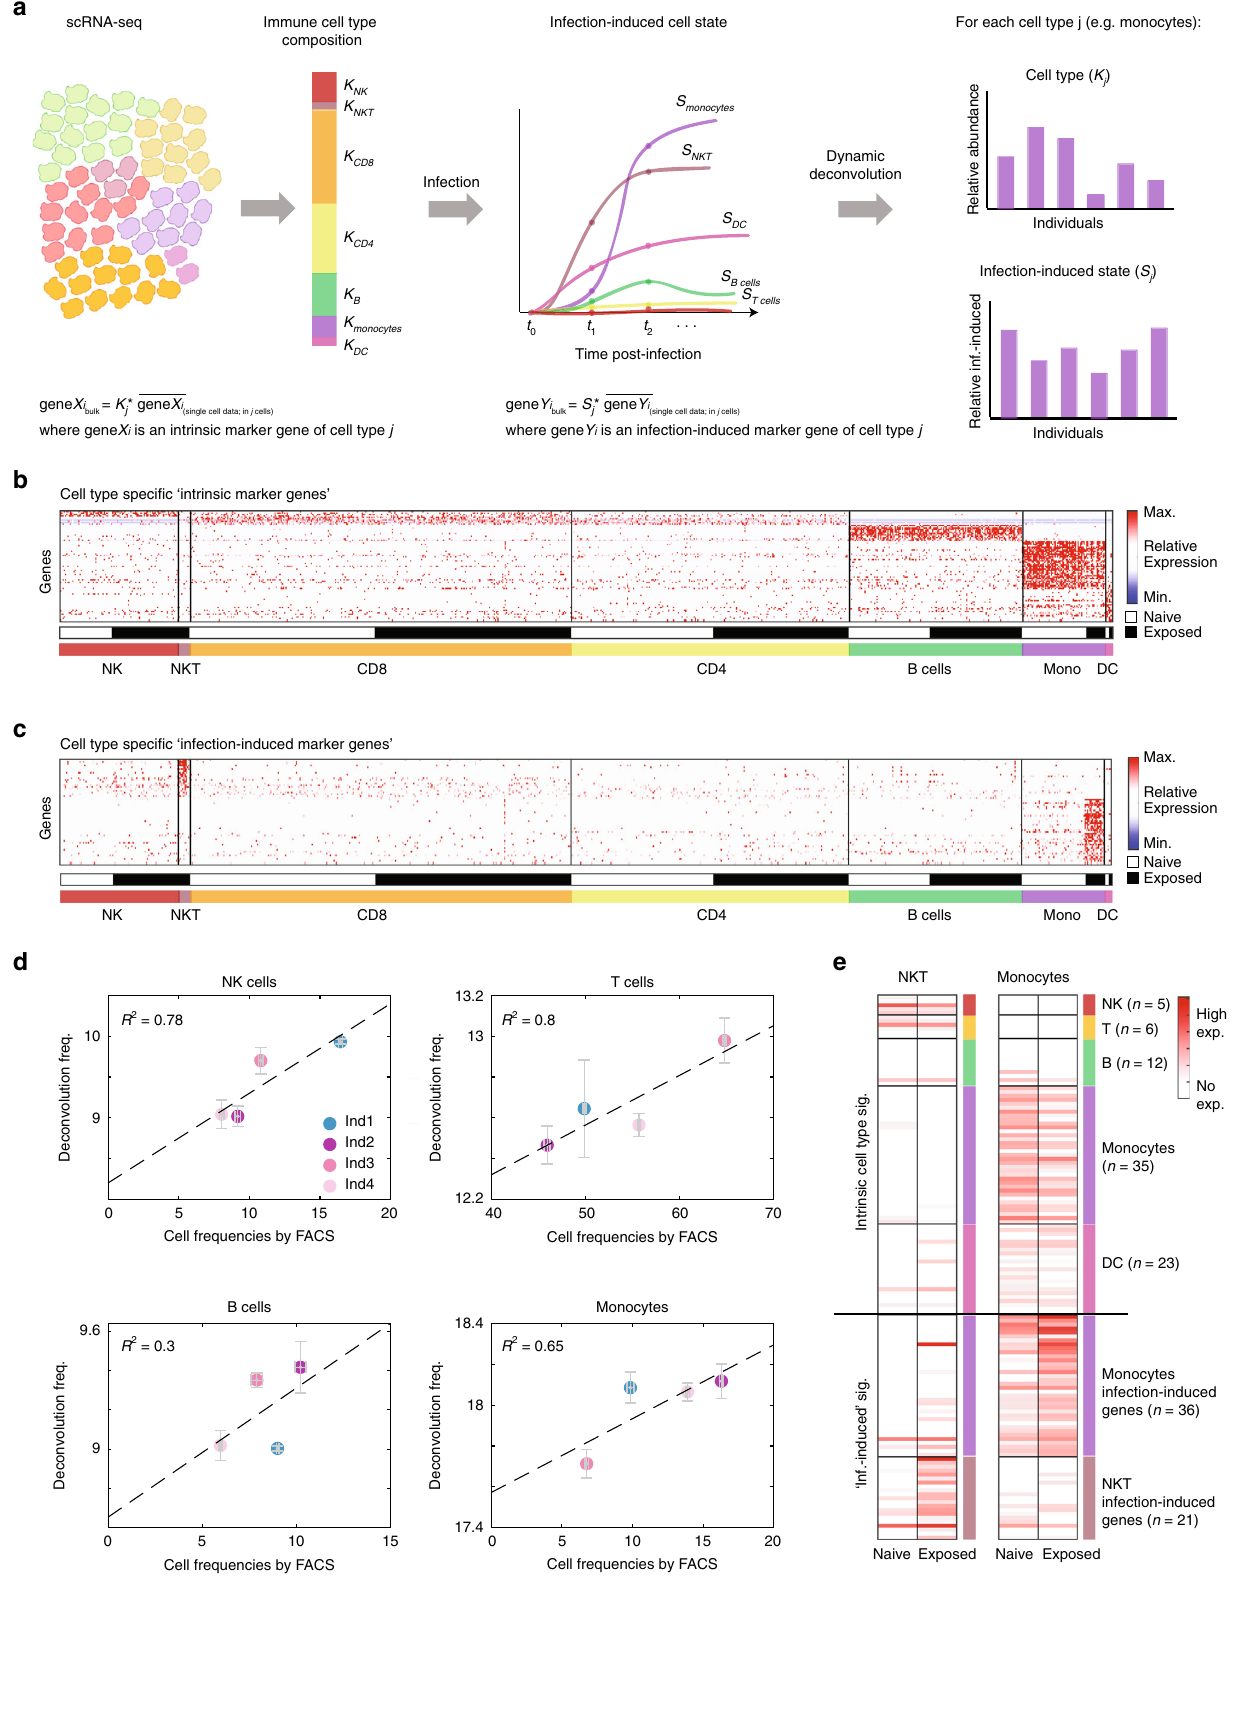
For each cell type j (e.g. monocytes):scRNA-seq